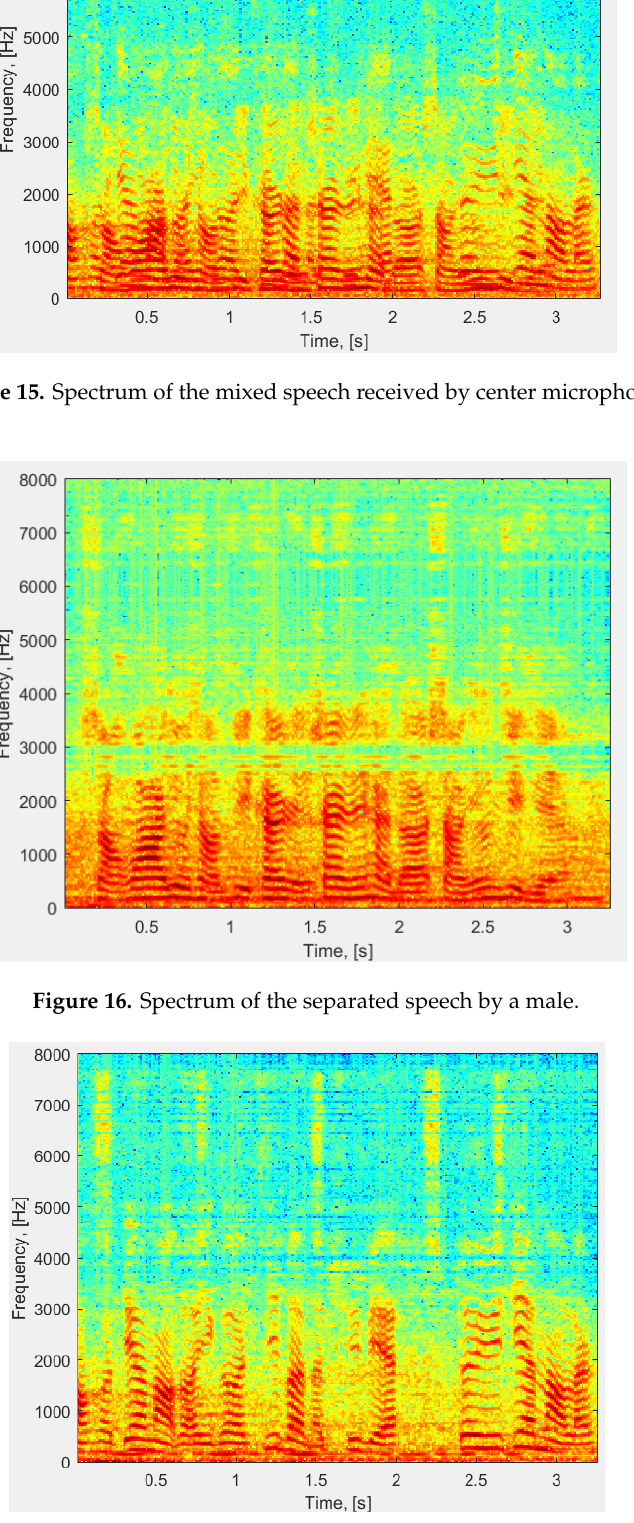
Figure 17. Spectrum of the separated speech by a female.